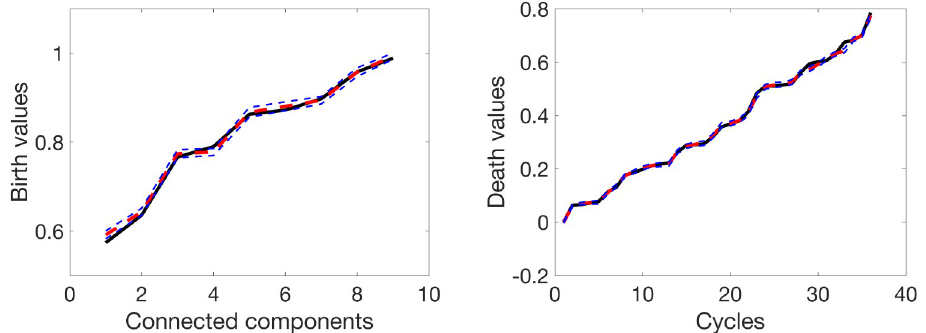
Fig 5. Plots of the original and expected birth (left) and death (right) values. The black line represents the original birth (or death) values, the dashed red line indicates the expected birth (or death) values, and the dashed blue lines indicate the corresponding 95% confidence intervals.